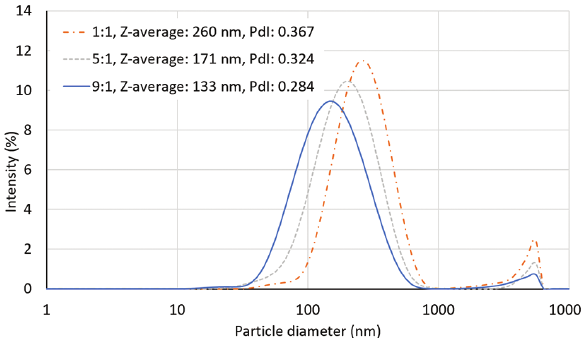
Figure 9: Overall PSD showing effect of antisolvent to solvent ratio at 12mL/s and 1200